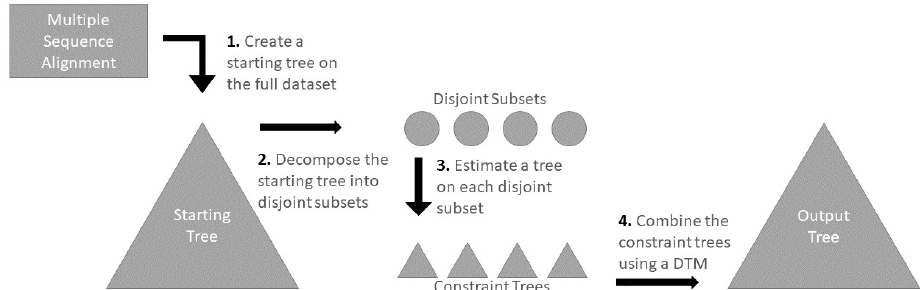
Figure 1. DTM Pipeline. Here, we show a step-by-step overview of the pipeline we study that uses Disjoint Tree Merger (DTM) methods to infer a tree. In Step 1, a tree is computed on the input multiple sequence alignment, which serves as a starting tree as well as providing auxiliary information used by the DTM. In Step 2, the starting tree is decomposed into multiple disjoint subsets; each subset defines a sub-alignment of the input alignment. In Step 3, a tree is inferred on each disjoint subset (i.e., alignment), which subsequently serve as constraint trees. In Step 4, these constraint trees are combined using a DTM (along with the auxiliary information provided by the starting tree) to form the final output